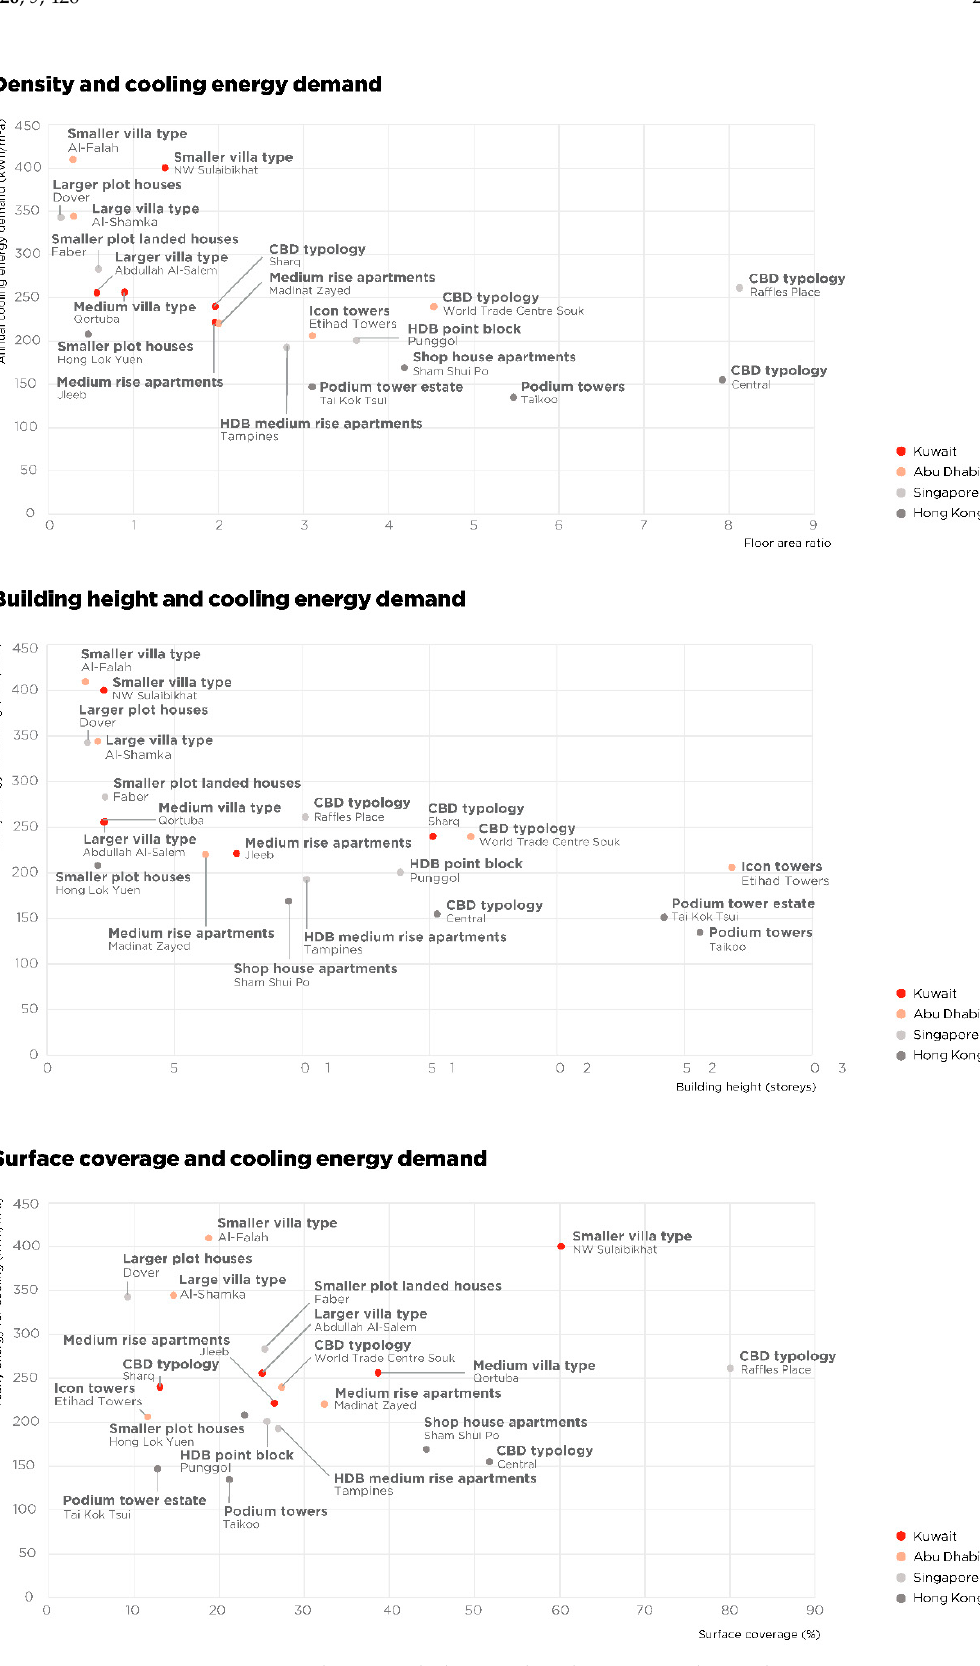
Figure 8. Urban morphology and cooling energy demand.